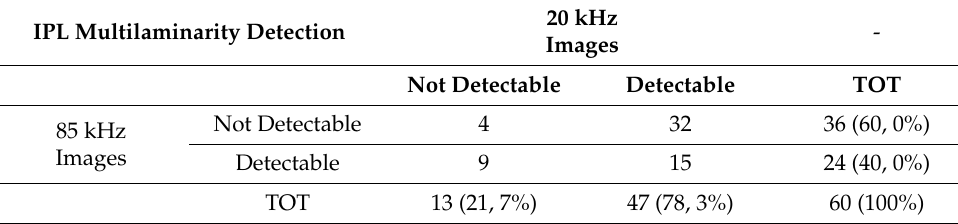
Table 4. Contingency table showing the number of images in which the IPL multilaminarity was detectable for the two different A-scan rate acquisitions.